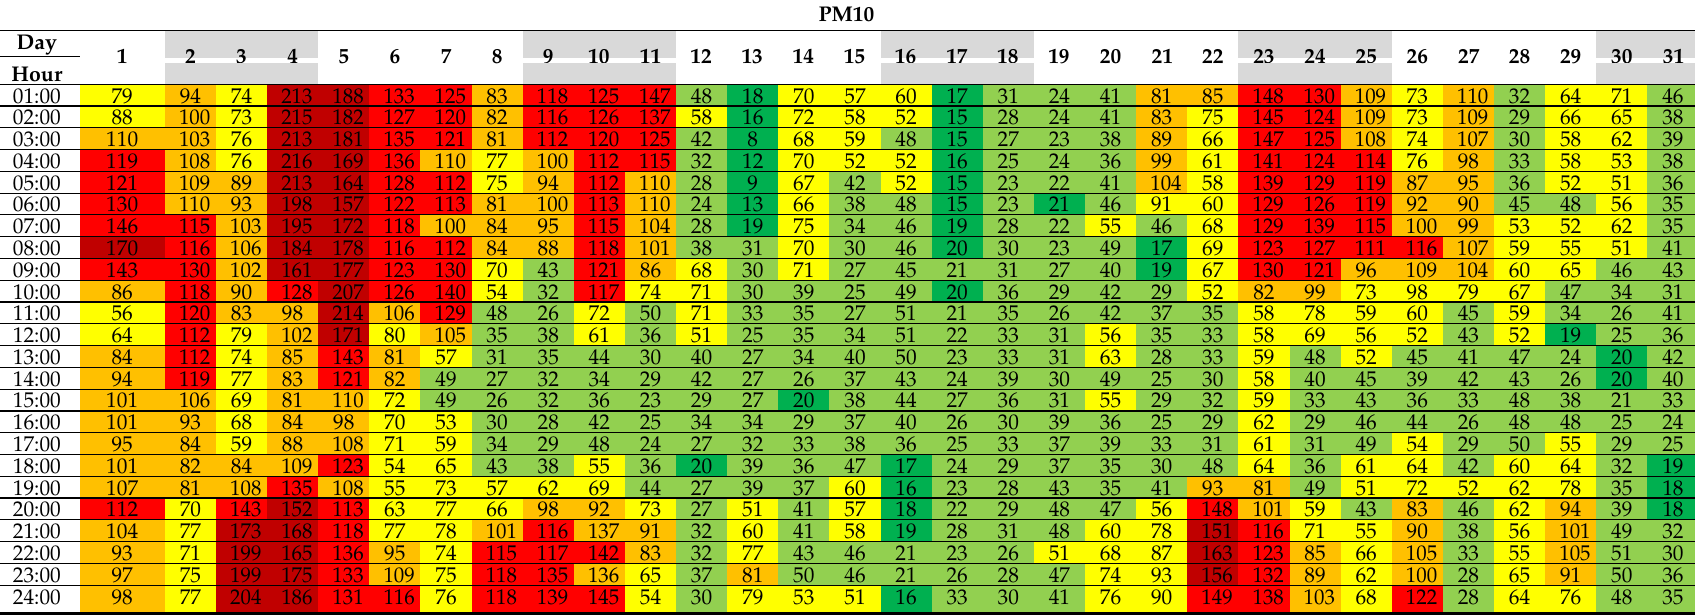
Table 2. Daily and hourly PM10 content changes, with the hourly Polish AQI, average values for Krak ó w, March 2018 [39] (weekend marking in